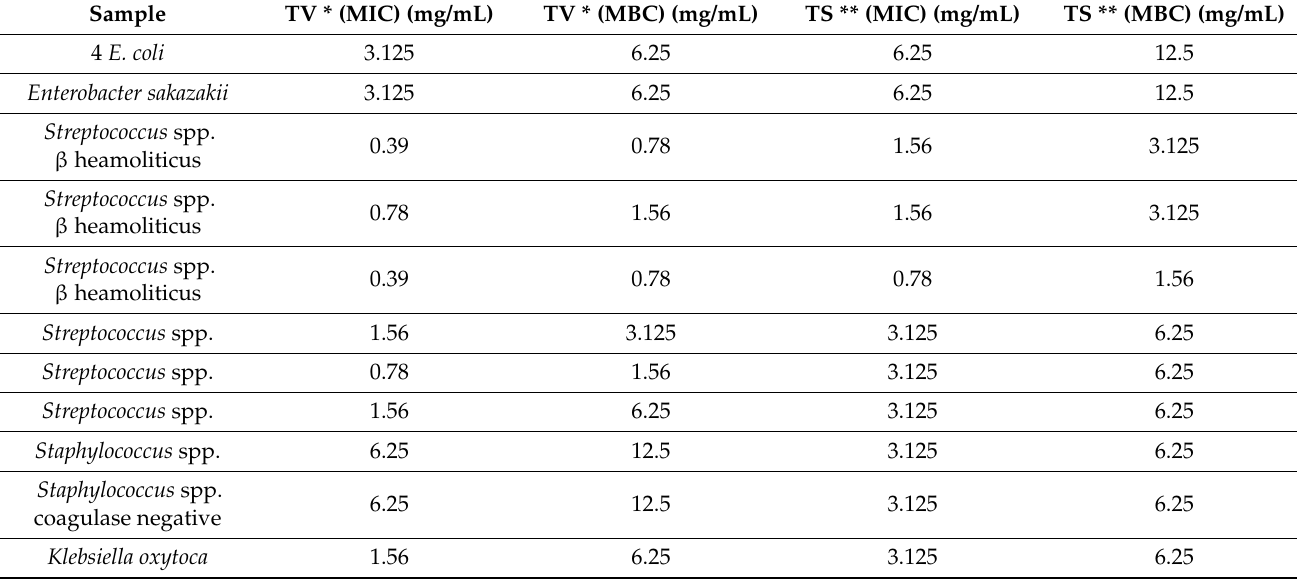
from 1.56 to 12.5 mg/mL. In the case of T. vulgaris, MICs ranged from 0.39 to 3.125 mg/mL, while MBCs ranged from 3.125 to 6.25 mg/mL. TV is more active against E. coli , E. sakazakii, and Streptococcus spp., while it is less effective against Staphylococcus spp. than TS. Table 4. Minimum inhibitory concentrations (MICs) and minimal bactericidal concentrations (MBCs) of T. serpyllum and T. vulgaris EOs against mastitis-associated